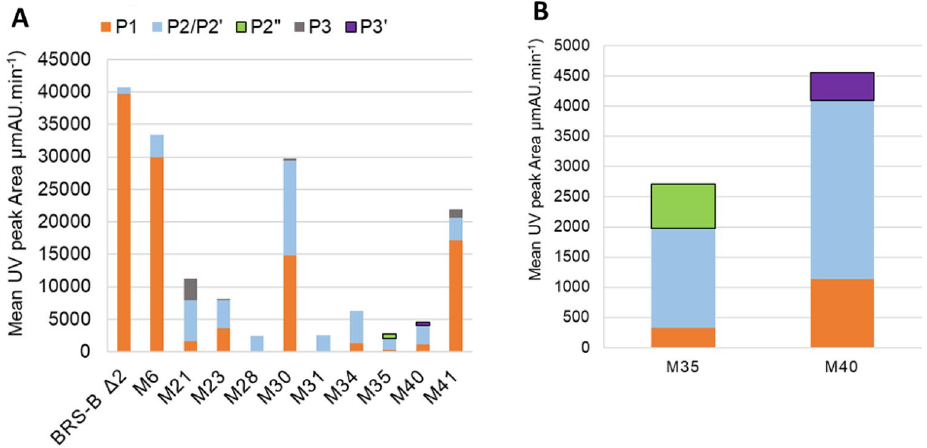
Figure 5. ( A ) Distribution of the products formed by BRS-B Δ2 enzyme and its mutants, and determined from HPLC–UV analyses of 16 h reaction mixture with 50 mM ABC’D’ , 1 M sucrose at pH 5.75 and variable amounts of purified enzymes in 50 µL reaction volume. Mass Spectrometry revealed a mass increase of 162 g mol −1 compared to ABC’D’ , corresponding to mono-glucosylated tetrasaccharides. M14 and M18 did not produce any pentasaccharide product (not shown). ( B ) An enlarged view of the products (notably novel products P2 ″ and P3’ ) formed by M35 and M40 is shown on the right